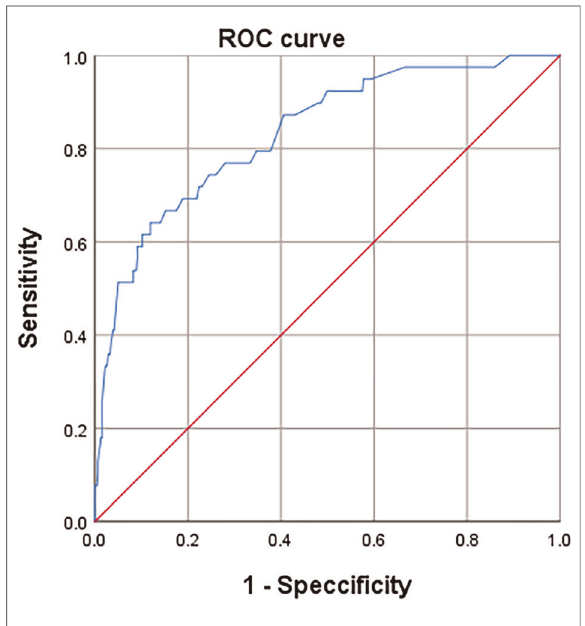
FIGURE 4 The ROC curve of the combined diagnostic index A for the diagnosis of preoperative